Question: Generate an informative caption for the figure above.
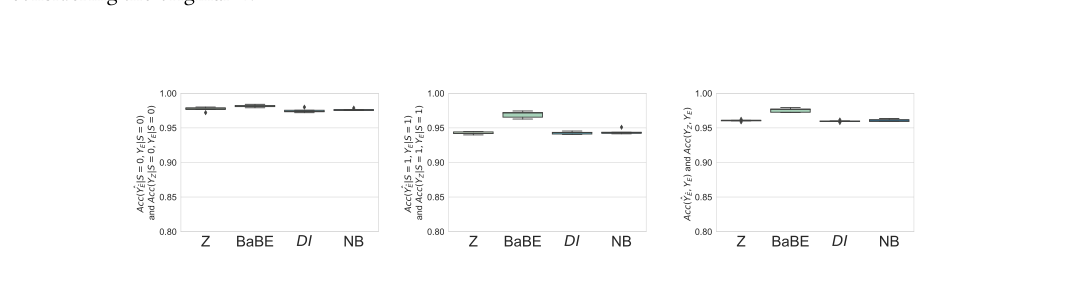
Answer: shows the accuracy resulting from the application of BaBE, DI, and NB to the NHANES data set. As we can